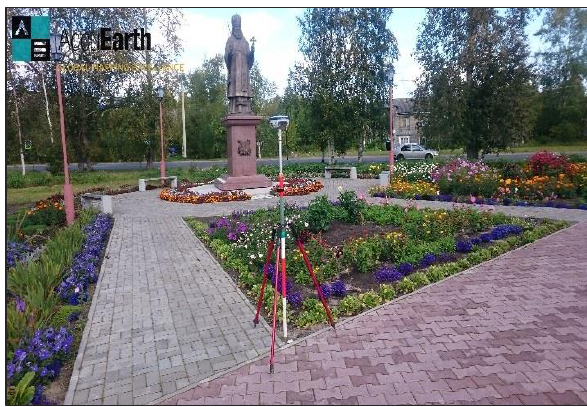
Figure 1. Clear Photo-identifiable GCP